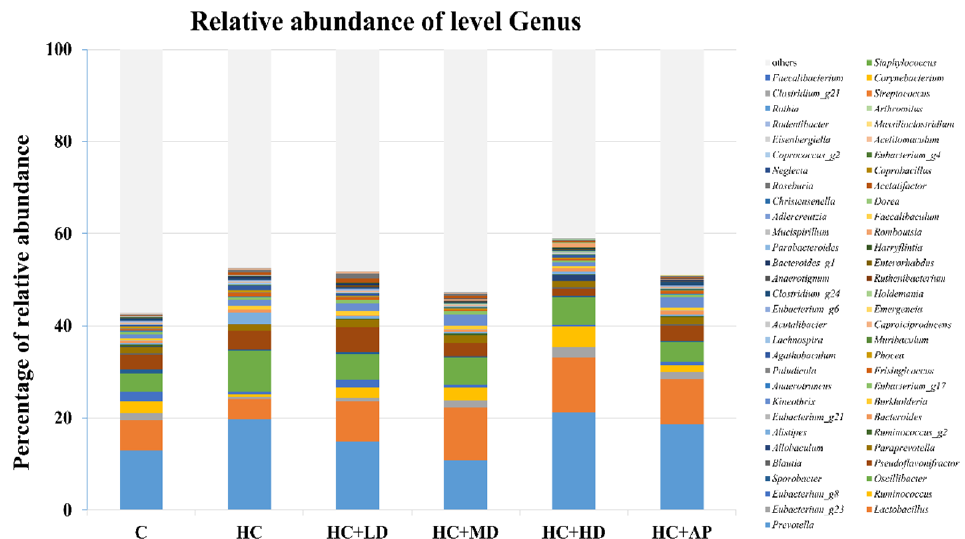
Figure 7. Effect of TCI227 on fecal microbiota genus-level compositions in PO-induced hyperuricemia rats. The reported values are means (n = 3).